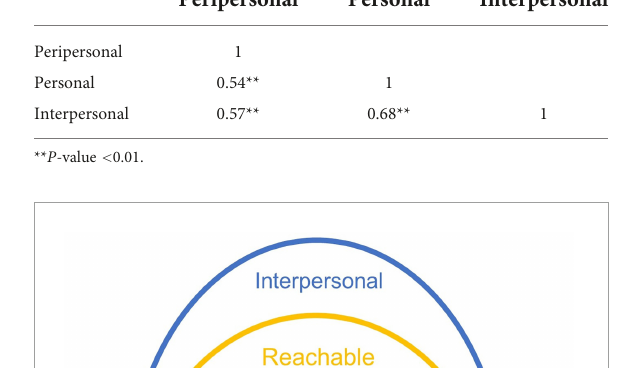
39) = 2.68, p Mask = 0.109, η 2 Mask = 0.06. There was, however, a significant interaction between Face mask and Gender on the perceived emotional valence, F (1, 39) = 9.13, p = 0.004, η 2 Mask = 0.19. Post-hoc paired t -test (corrected with Bonferroni) further indicated that unmasked male characters were perceived noticeably more negative ( M ± SE = 48.84 ± 2.28) than masked male characters (53.96 ± 2.25), t (39) = 2.31, p = 0.024, while there was no difference between the masked (54.22 ± 2.43) and unmasked (56.20 ± 2.45) female characters.